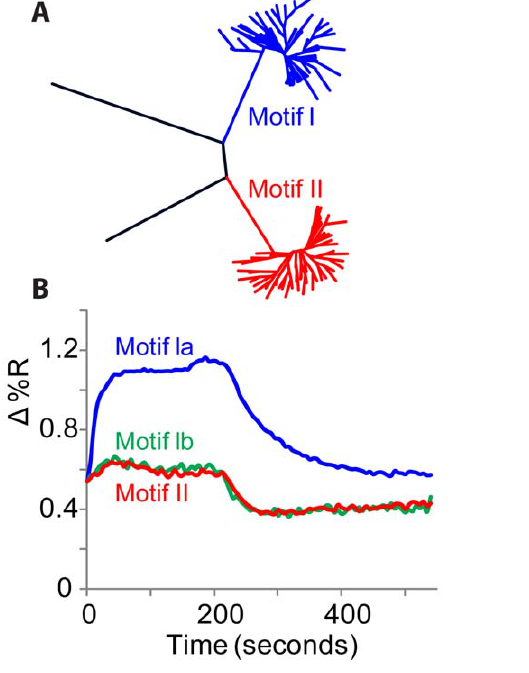
Table 3. Aptamer sequences and K d values (in m M). a